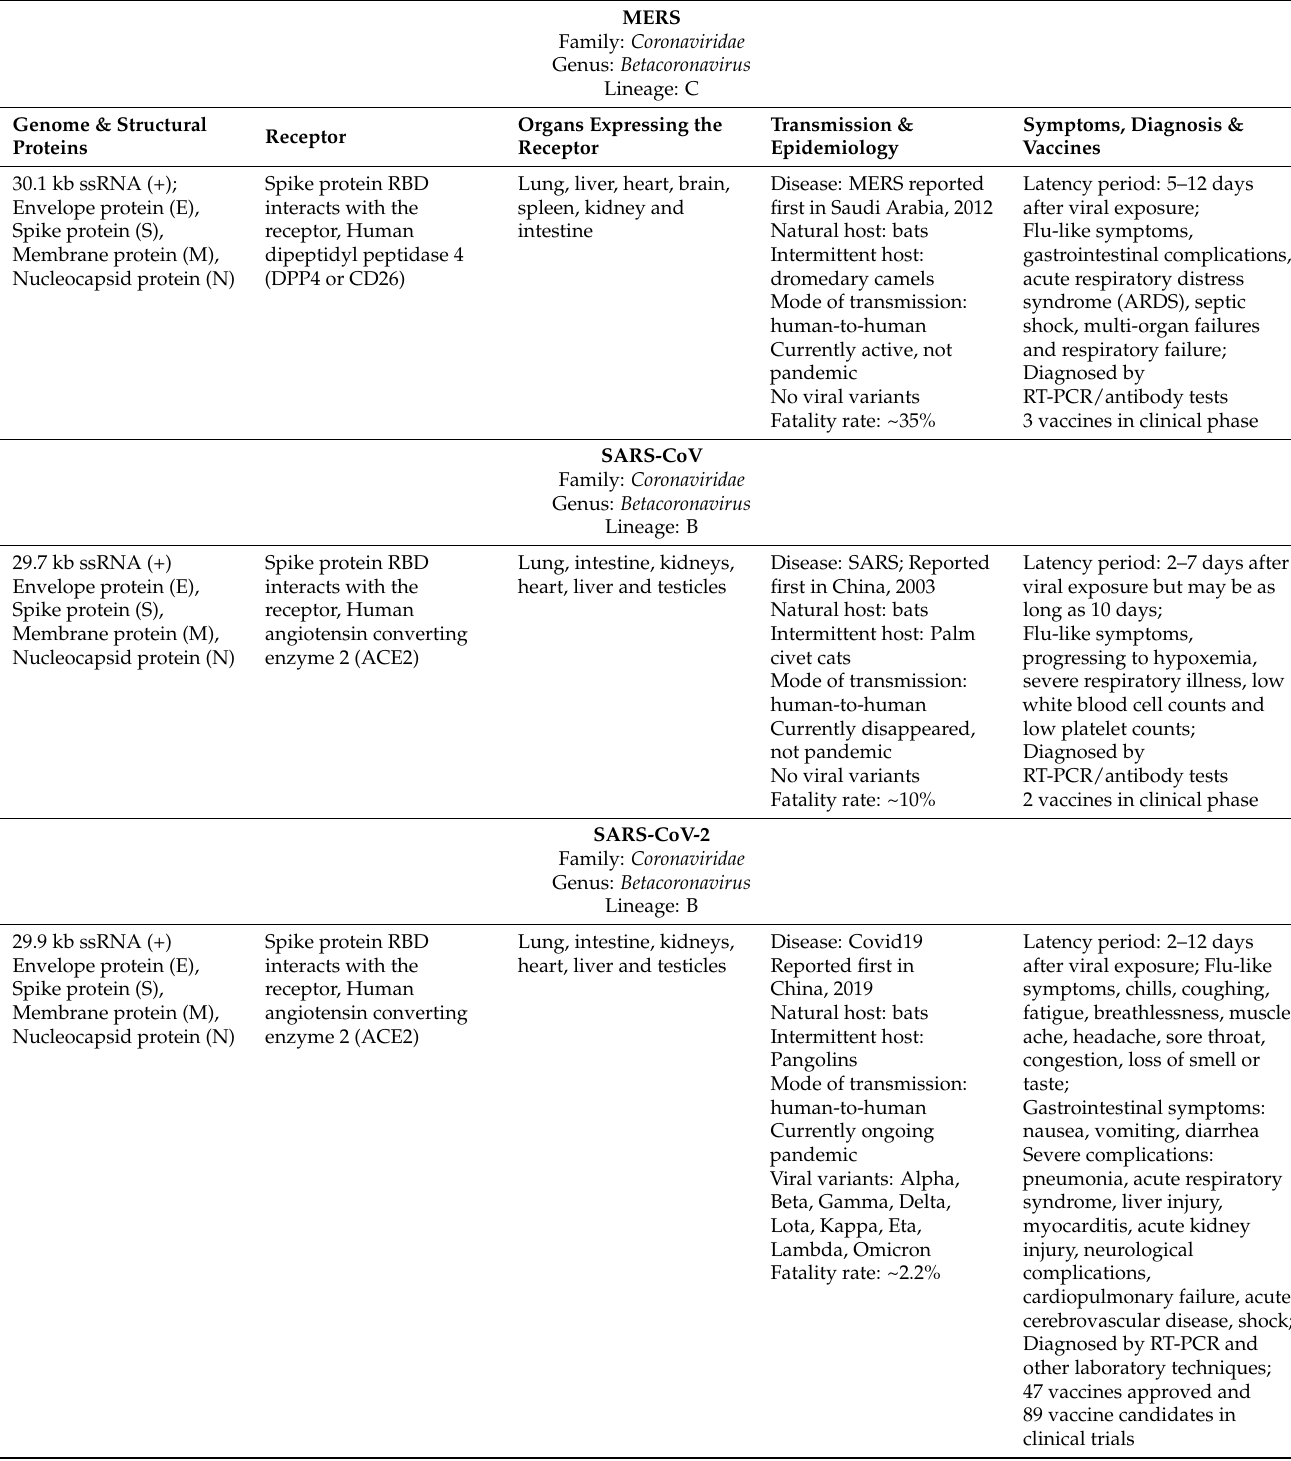
Table 1. Important features of Coronaviruses (Adapted from